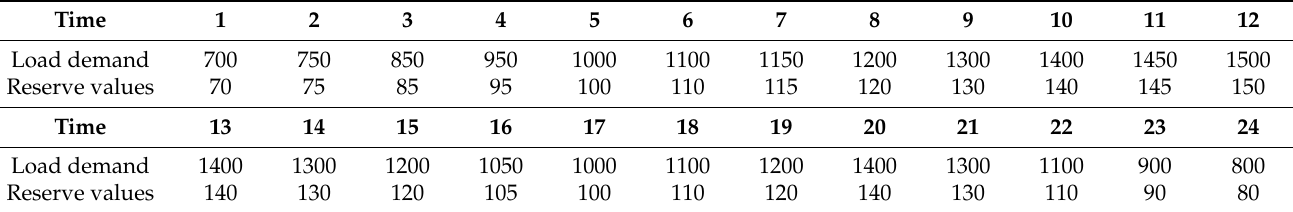
Table 2. Load and reserve data (test system 1) [23].